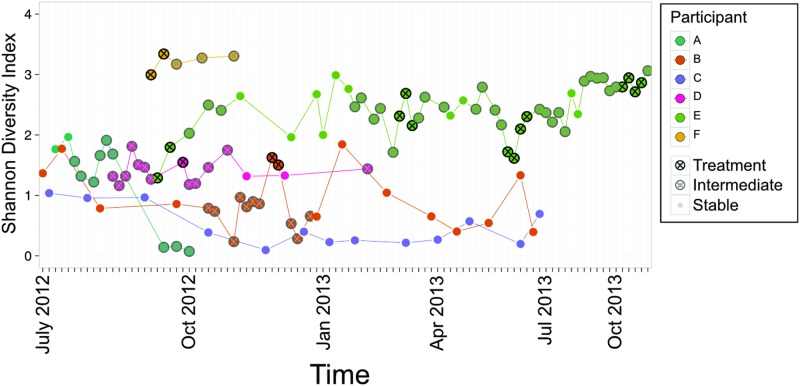
Diversity within the lung community does not consistently decrease with exacerbation.A longitudinal representation of the evenness and richness of the CF lung microbiota across study participants indicates patient-specific levels of within-patient diversity.